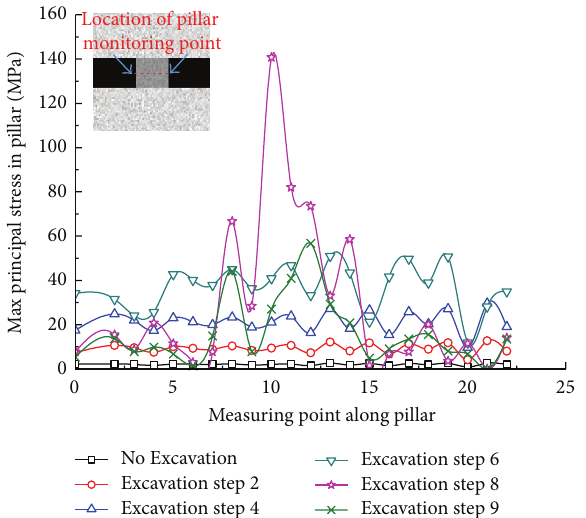
Figure 30: Pattern of stress change within the pillar during the excavation process, 𝑊/𝐻 = 1.5